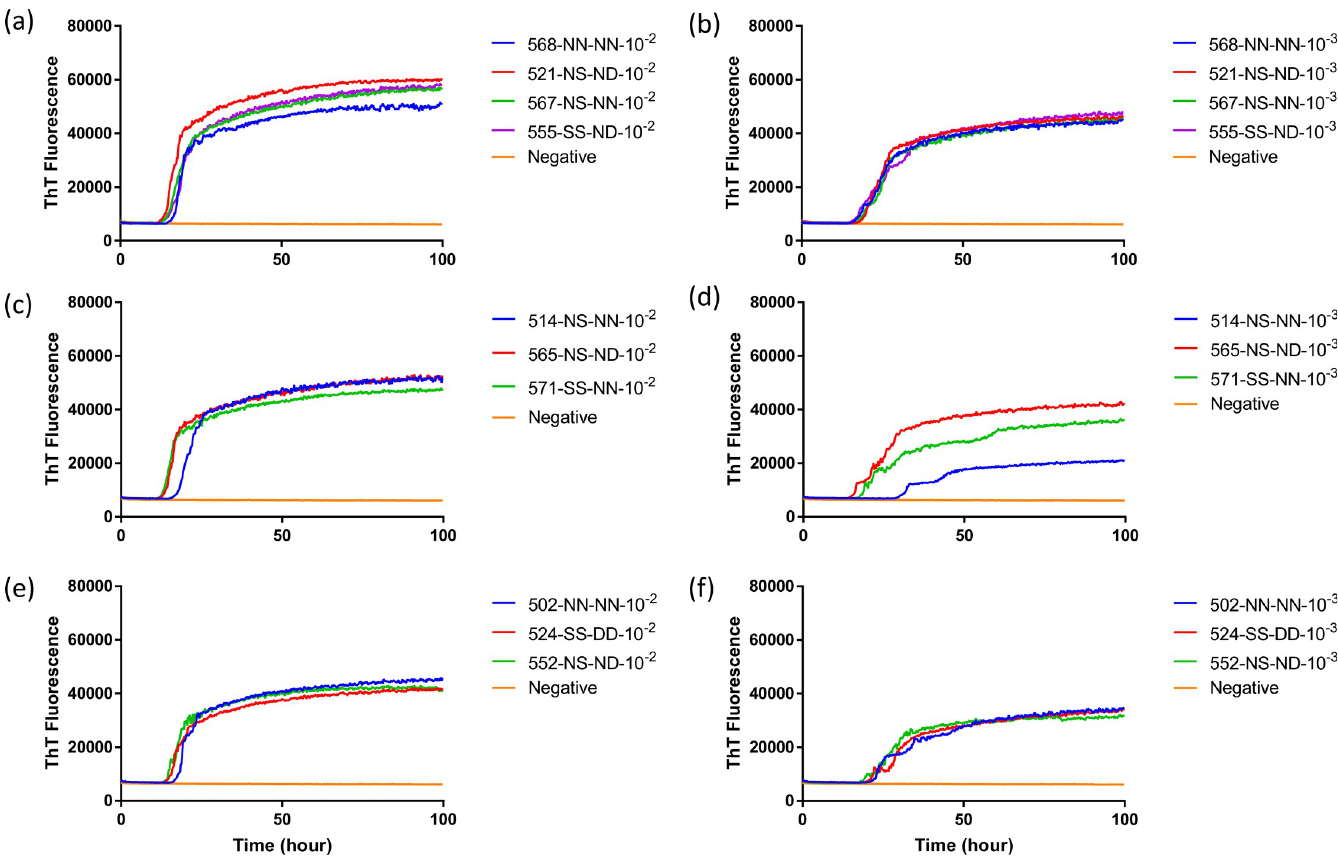
Fig 7. Comparison of seeding activity of RT-QuIC reactions with BV rPrP which contain seeds from reindeer inoculated with brains of infected WTD (a and b), elk (c and d) or mule deer (e and f). Left panel shows RT-QuIC reactions seeded with 10 − 2 brain dilution of EIA normalized and right panel shows RT-QuIC reactions seeded with 10 − 3 dilutions of brains. Data are presented as mean ThT fluorescence of 4 repeated reactions.